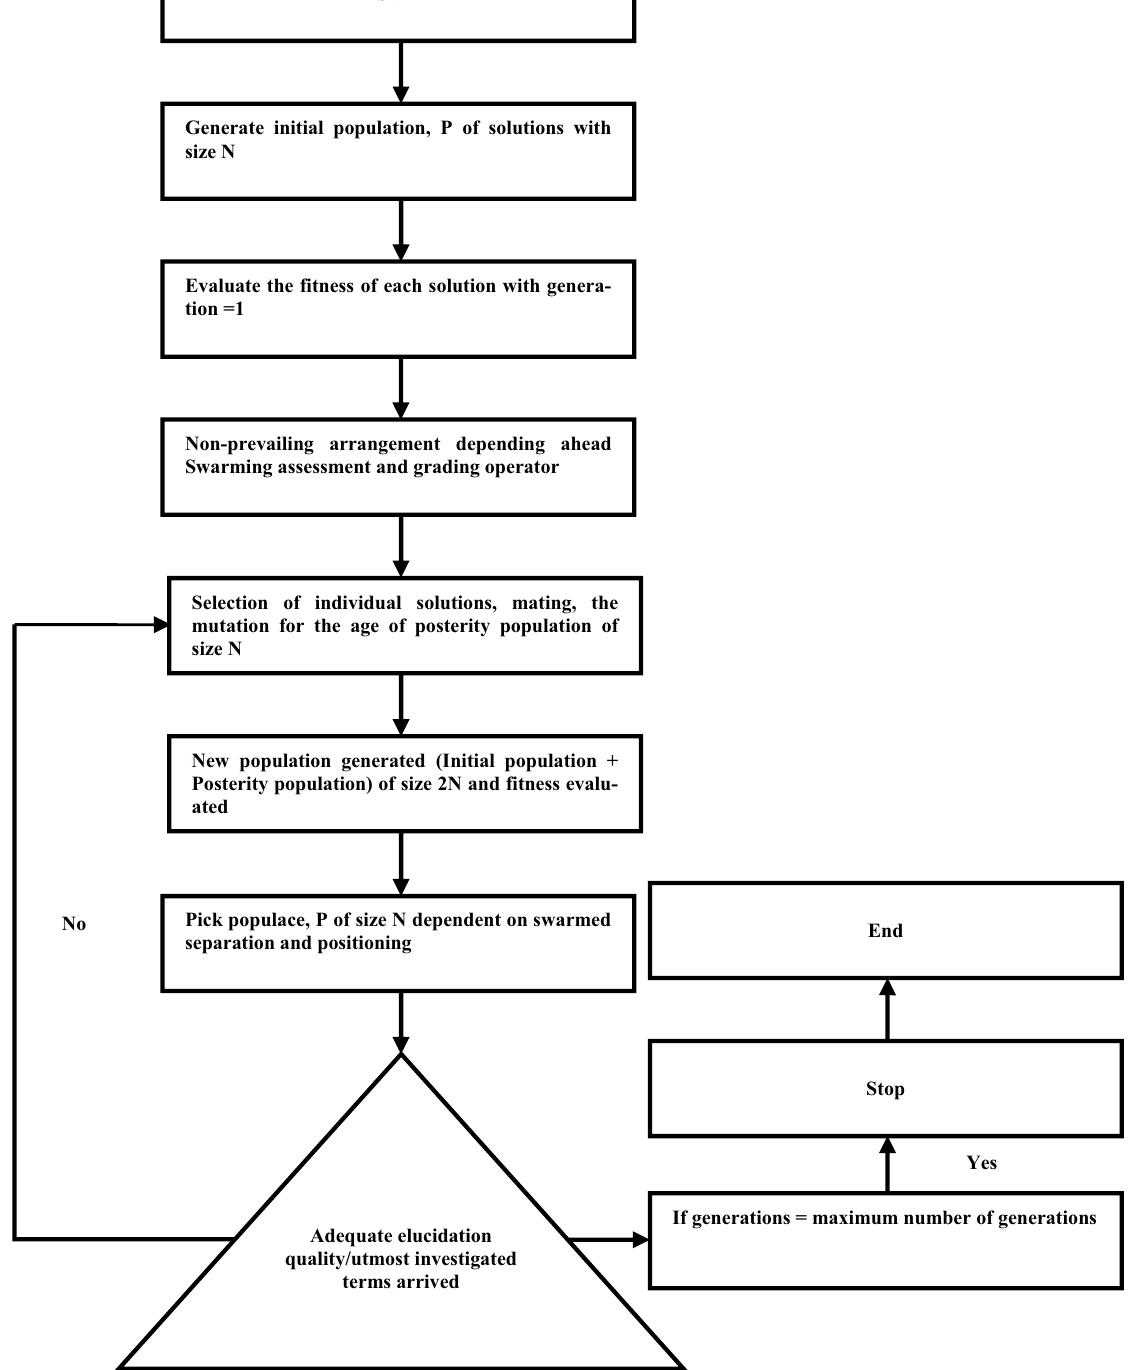
Figure 13: NSGA - II genetic